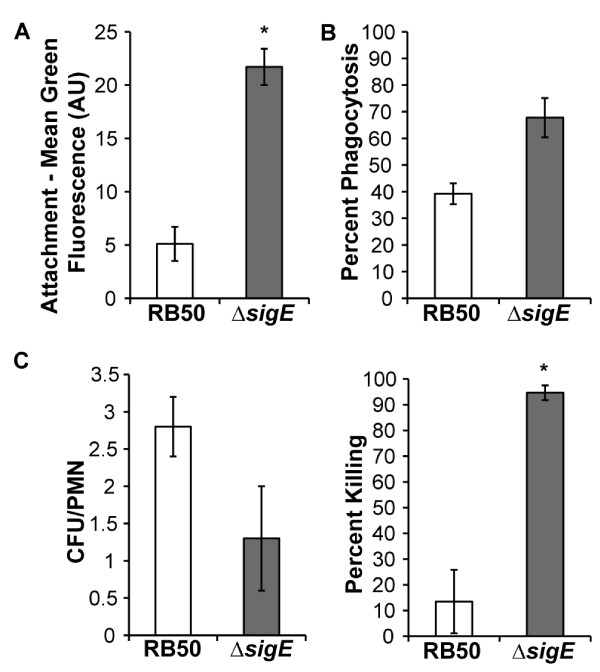
RB50ΔsigE is more efficiently phagocytosed and killed by PMNs than RB50. (A) GFP-expressing RB50 (white bars) and RB50ΔsigE (grey bars) were incubated with freshly isolated human peripheral blood PMNs for 20 min at an MOI of 50. Attachment levels were measured as mean intensities ± SE of green fluorescence associated with PMNs. (B) Cell surface-bound bacteria were detected by incubation with RPE-labeled goat F(ab’)2 fragments of anti-mouse IgG, after incubation with immune serum. Mean phagocytosis levels ± SE were calculated from the decrease in red fluorescence of GFP-positive cells incubated for an additional 30 min at 37°C allowing for internalization (RPE2, 50 min total incubation time) compared to that of cells incubated for only 20 min (RPE1). Percent phagocytosis is (1-RPE2/RPE1) × 100%. (C) To determine killing of bacteria by PMNs, cells incubated with bacteria for 50 min were treated with antibiotics to kill extracellular bacteria. Viable bacteria per PMN (left) and percent killing of internalized bacteria (right) were expressed as mean ± SE. AU indicates arbitrary units; * indicates a P-value of < 0.05.